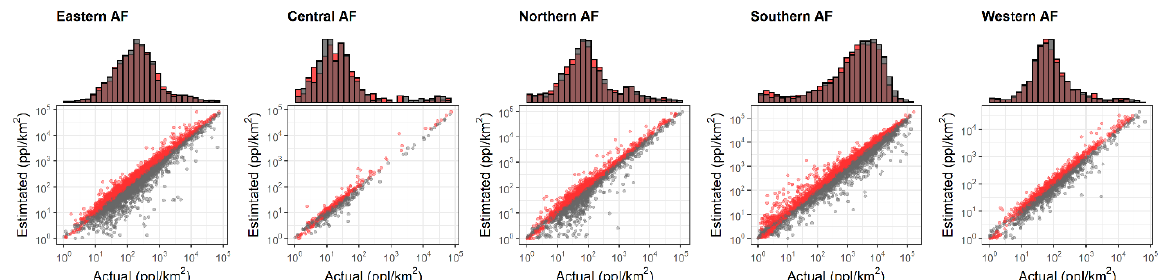
Figure 6. Scatter plots of estimated population density and actual population density for the validation units of each country within each region. Marginal histograms depict the concentration of underestimations (grey) and overestimations (red). Each panel shows the log population density.